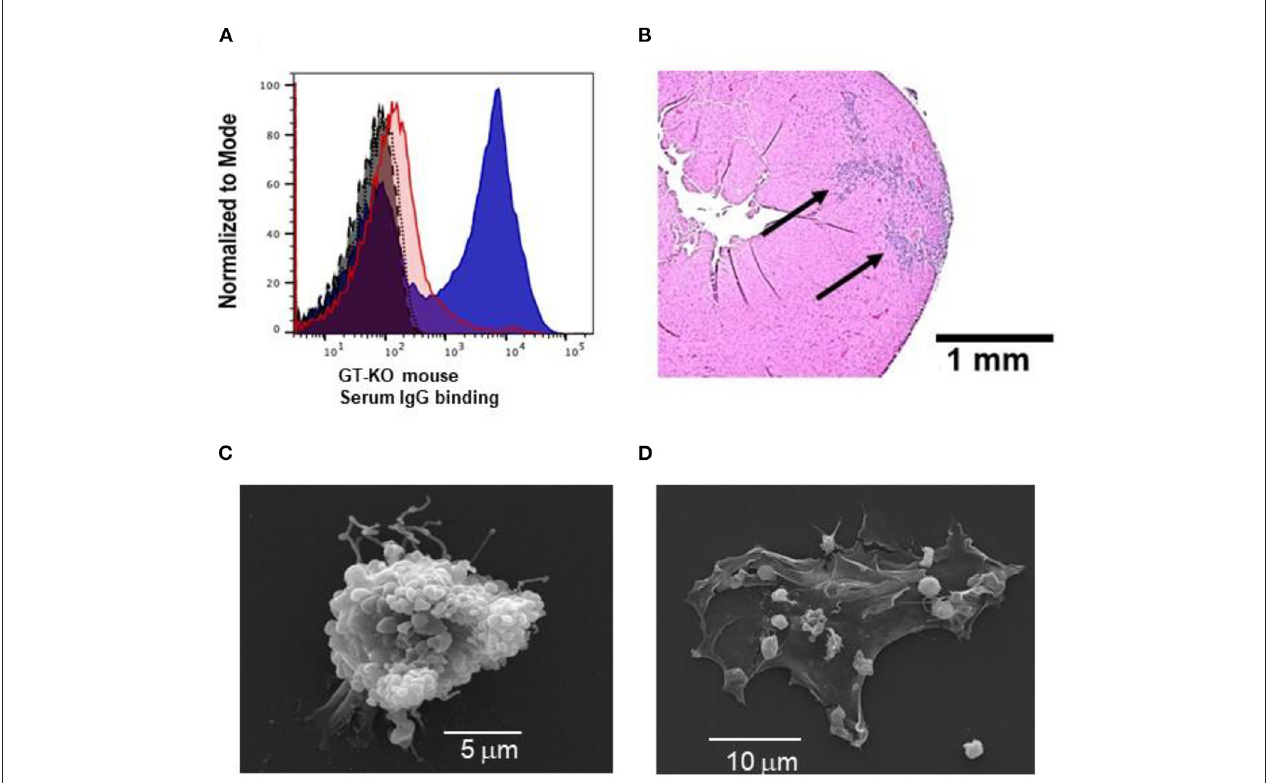
FIGURE 2 | Characteristics of anti-Gal interaction with α -gal nanoparticles: (A) Flow cytometry evaluation of anti-Gal IgG binding to α -gal nanoparticles (blue) (representing Stage 1 of Figure 1 ); nanoparticles lacking α -gal epitopes (red), isotype-control (gray), auto-fluorescence without antibodies (black). (B) In vivo recruitment of macrophages by α -gal nanoparticles, 4 days post-injection of the nanoparticles into normal uninjured mouse heart (also representing Stage 1 of Figure 1 ). The section is in a representative heart of 4 hearts with similar results. Arrows – macrophages infiltrating two injection sites. Staining by hematoxylin-eosin (H&E). (C) Scanning electron microscopy of anti-Gal-coated α -gal nanoparticles binding to a macrophage (representing Stage 2 in Figure 1 ). (D) As (C) however the initial concentration of the applied α -gal nanoparticles is 100-fold lower, thus the cell membrane of the macrophage is visible.